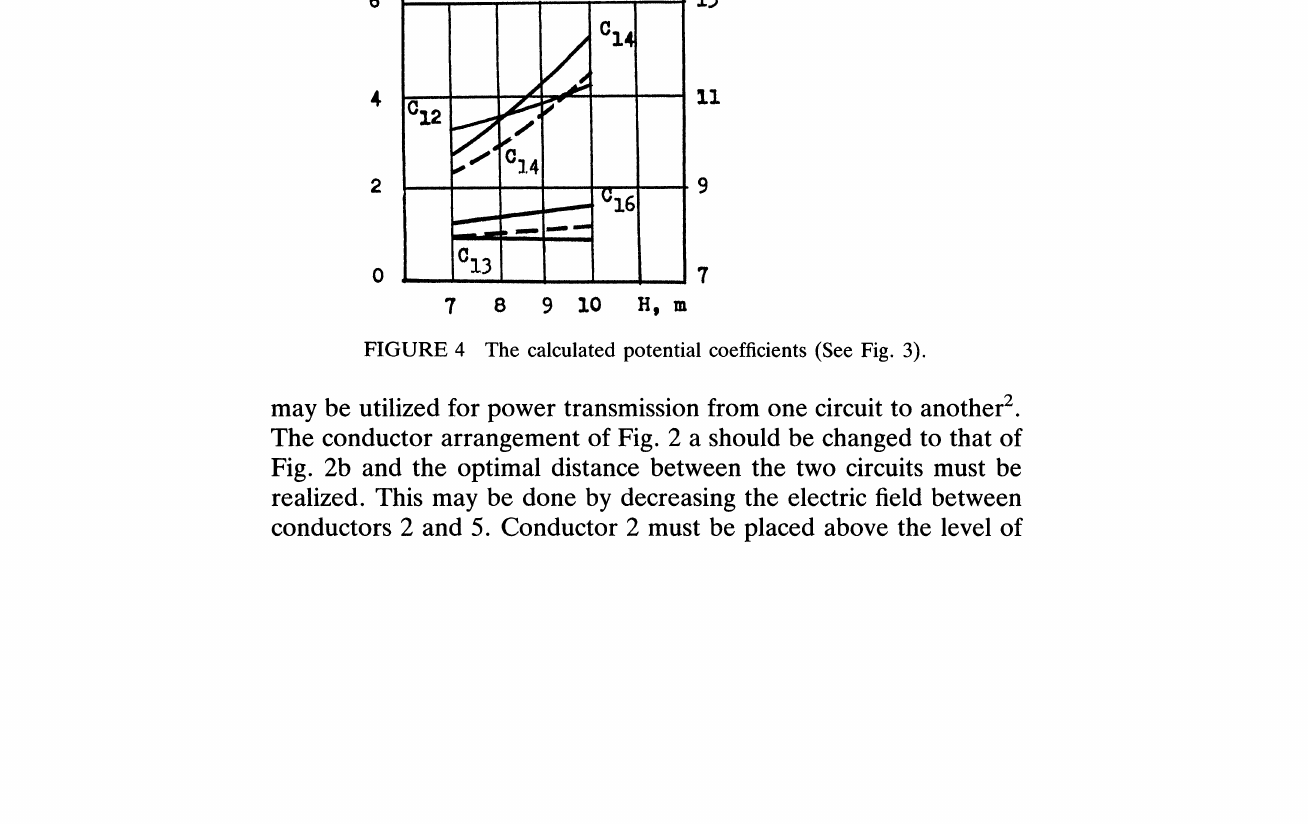
FIGURE 3 The calculated inductances with different heights when the distance between conductors 4 and 6 is 39 m: for distance between conductors & 3 31 m for 23 m between conductors & 3. km/,uP for dotted